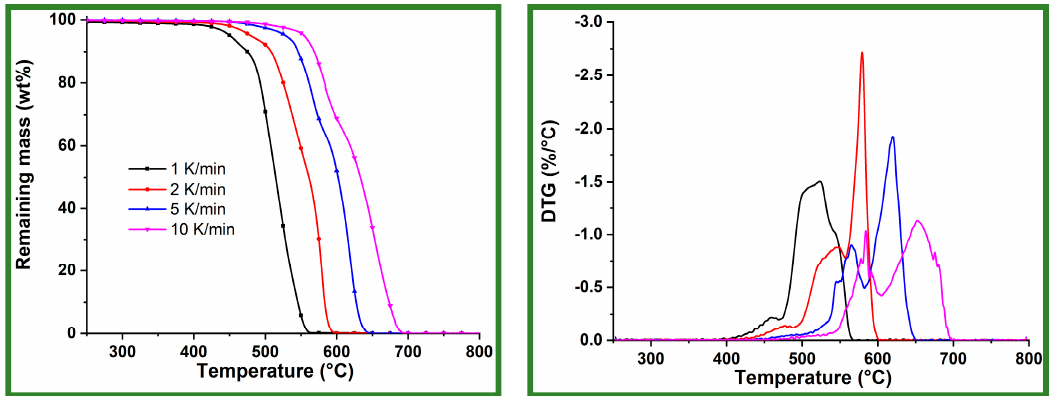
Figure 13. TG (left) and the corresponding DTG (right) curves of PEEK at 1 (black), 2 (red), 5 (blue), Figure 13. TG ( left ) and the corresponding DTG ( right ) curves of PEEK at 1 (black), 2 (red), 5 (blue), and 10 K/min (magenta), in air. and 10 K / min (magenta), in